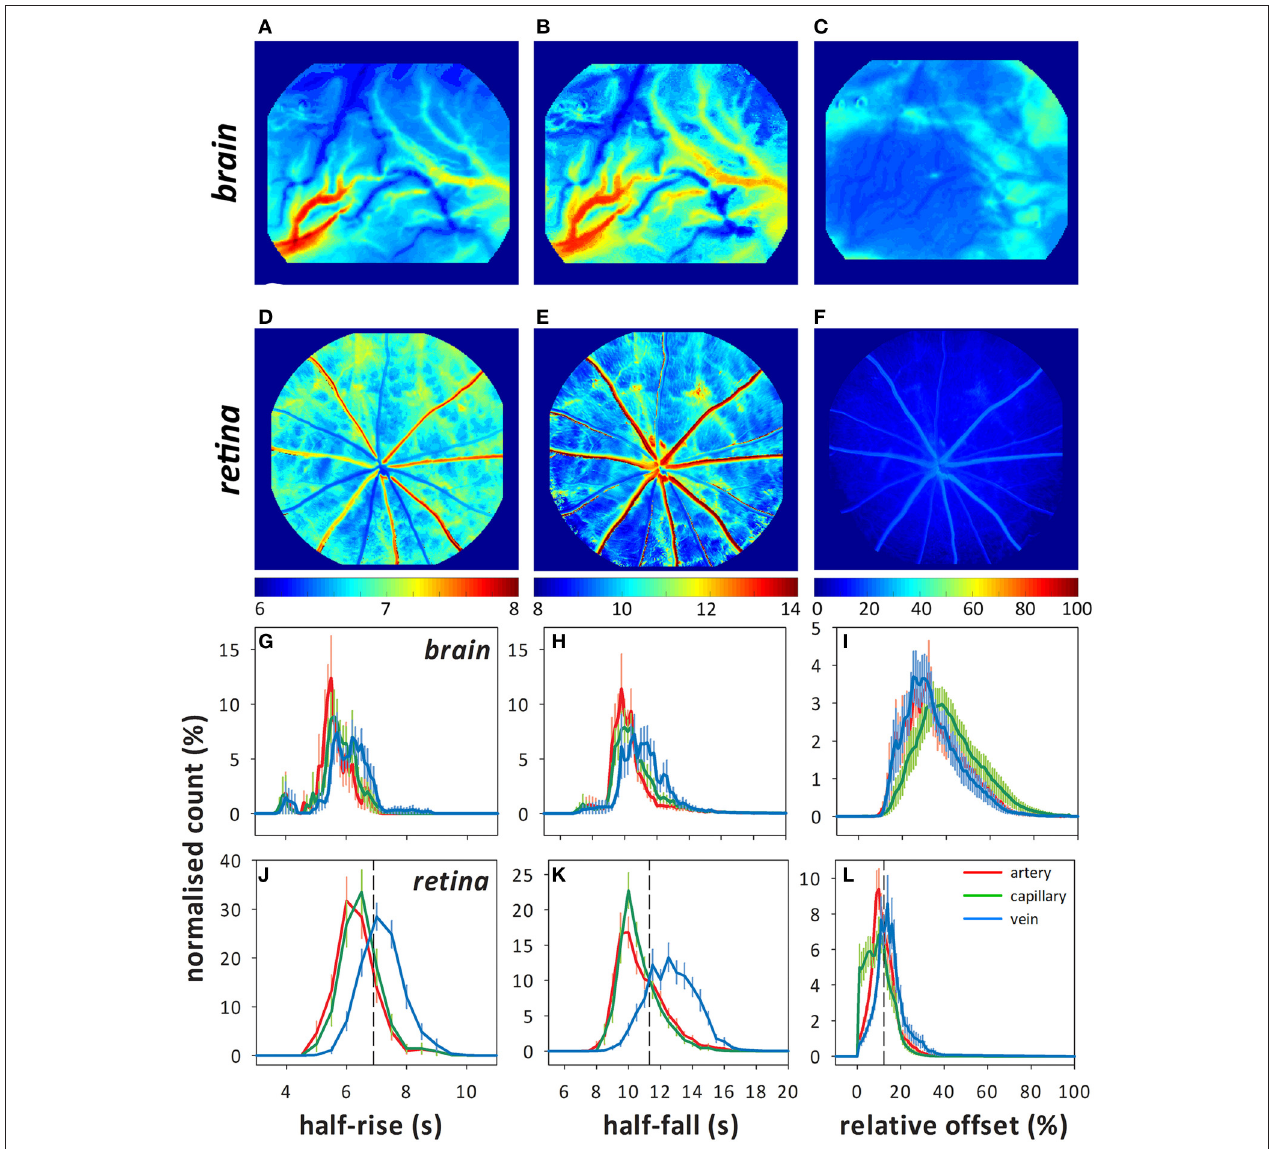
FIGURE 2 | Representative color maps showing the fluorescence indices (half-rise, half-fall, and offset) determined using pixel-by-pixel analysis in the brain (A–C) and retina (D–F) . Frequency histograms (normalized count to total number of pixels, %) for each index in the brain (G–I) and retina (J–L) showing the distribution of the fluorescence indices for arteries (red), capillaries (green), and veins (blue). Dashed lines in (J–K) indicate where the 75% quartile lies for the capillary data, which is used for calculating the index of